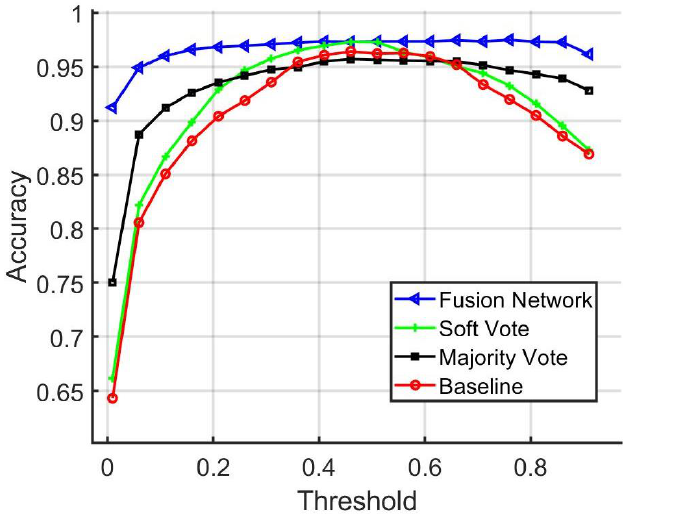
Figure 18. Comparison of baseline, majority vote, soft vote, and fusion network matching accuracy.